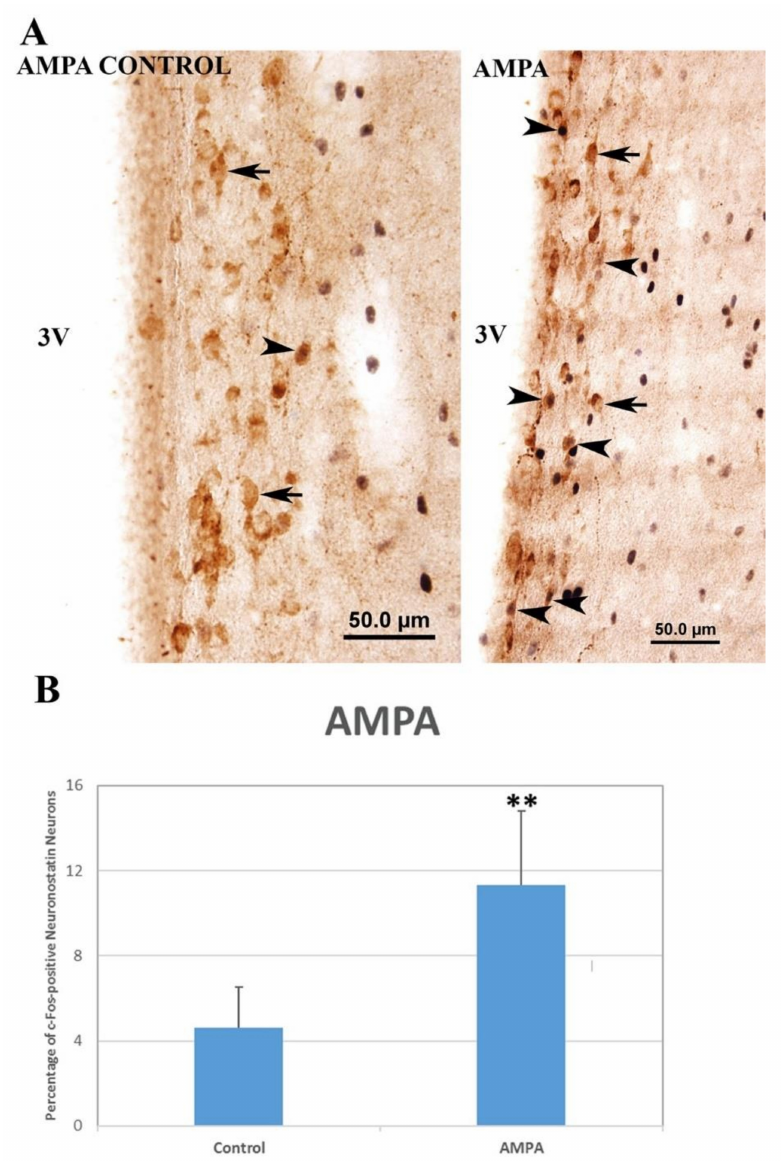
Brain Sci. 2020 , 10 , x FOR PEER REVIEW 7 of 14 neuronostatin neurons after 48 h fasting (on the left), pSTAT5 expression in neuronostatin neurons activated with refeeding in anterior hypothalamic periventricular nucleus (in the middle), neuronostatin neurons in the anterior periventricular nucleus in CNQX-treated subjects before Figure 5. The e ff ect of AMPA administration on c-Fos expression in neuronostatin neurons located in feeding (on the right) ( A ). pSTAT5 protein-expressing neuronostatin neurons ( ▲ ) and pSTAT5- the anterior hypothalamic periventricular nucleus. c-Fos protein-expressing neuronostatin neurons ( (cid:78) ) negative neuronostatin neurons (  ). 3V: third and c-Fos-negative neuronostatin neurons (